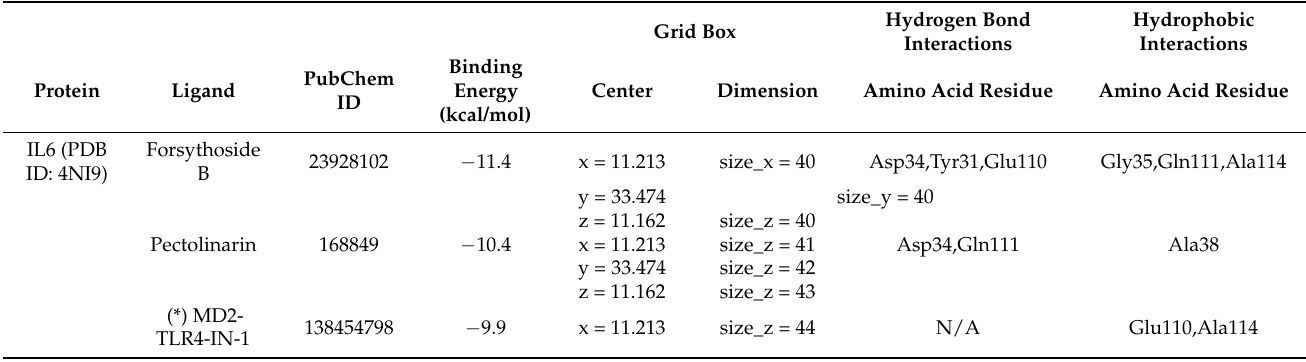
Table 3. Binding energy of 31 known IL-6 inhibitors (<1000